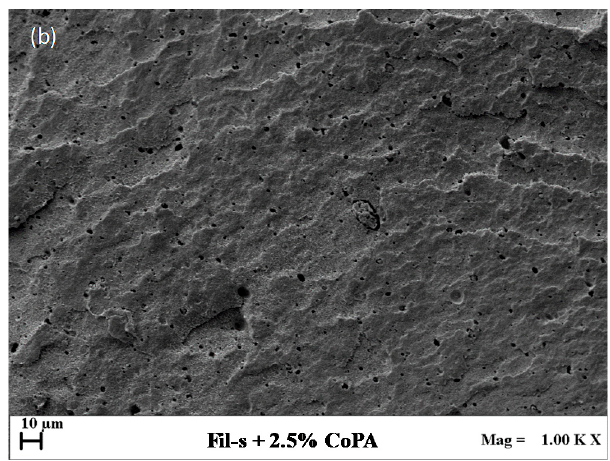
Figure 3 . SEM images, captured on the sections of the samples cryo-fractured and etched with formic acid, for ( a ) neat Fil-s and ( b ) Fil-s + 2.5%CoPA blend.